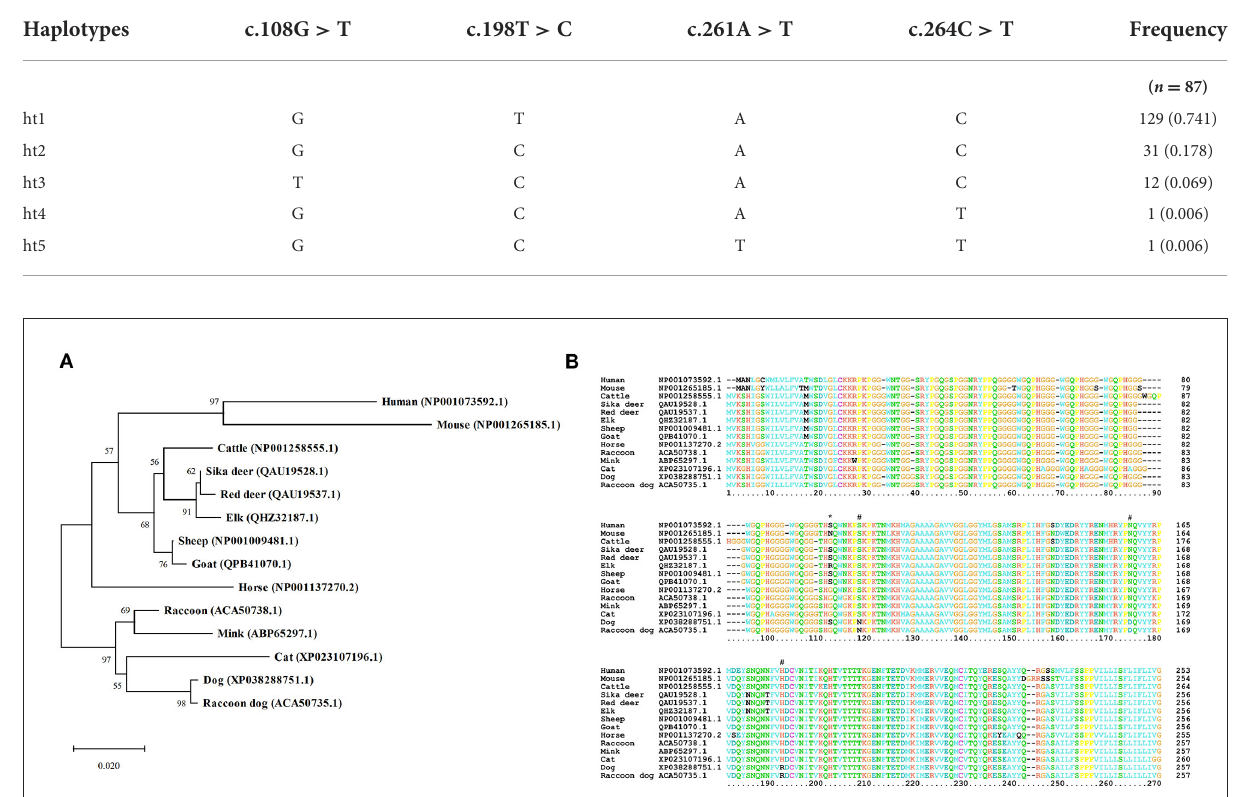
FIGURE2 Phylogenetic tree and comparison of amino acid sequences of prion proteins (PrPs) in 14 species. (A) A phylogenetic tree was constructed by MEGA X using amino acid sequences of the PrPs from 14 species. Detailed information on the 14 species is described in Supplementary Table 1. The phylogenetic tree was drawn using neighbor-joining methods with 5,000 bootstraps. The length of the branches indicates the evolutionary distance. (B) Multiple sequence alignment was performed by ClustalX using PrP sequences of the 14 species described in Supplementary Table 1. The colors of the text indicate the chemical properties of amino acids (green: polar uncharged; blue: hydrophobic; cyan: negatively charged; red: positively charged; orange: glycine; yellow: proline; pink: cysteine; black: out of consensus). The asterisk indicates a raccoon dog-specific amino acid. Sharps indicate Canidae family-specific amino